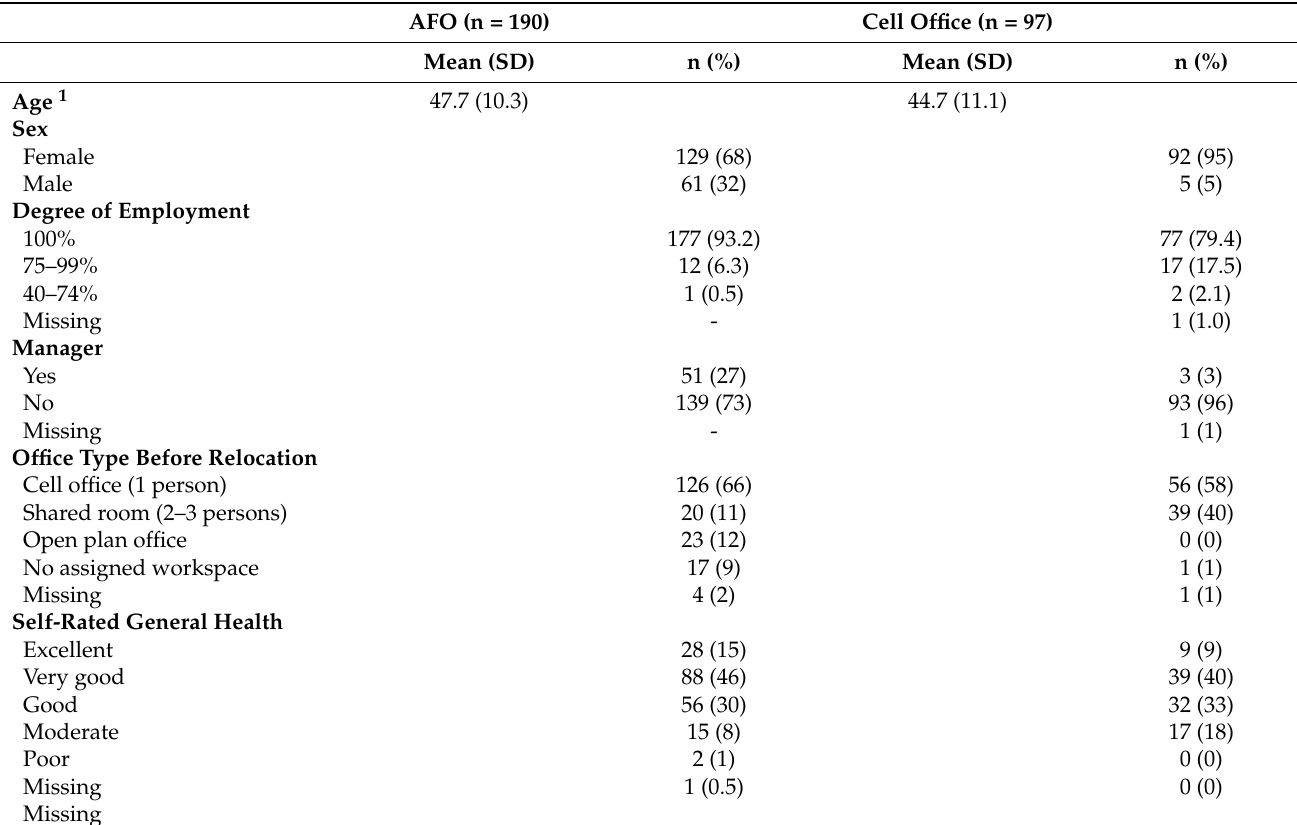
Table 1. Baseline descriptions of participants in the activity-based flex office (AFO) and cell office group,